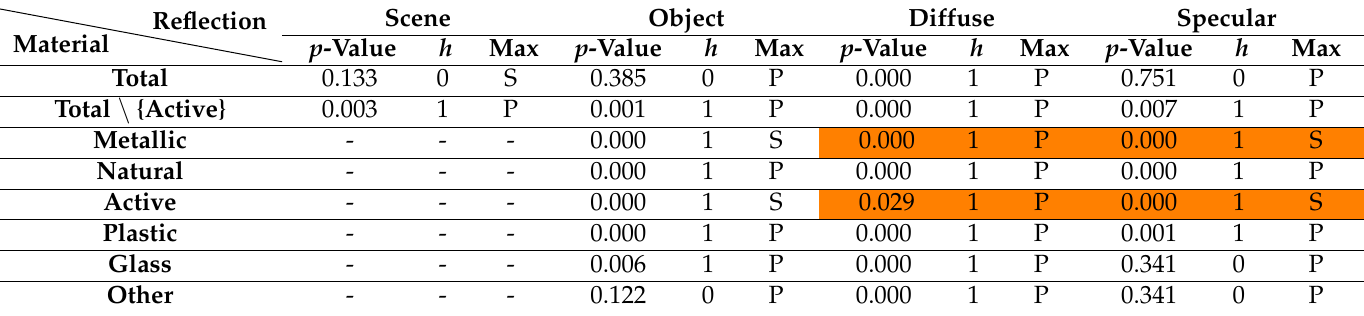
Table 5. Mann–Whitney U tests p -values and h for the 26 scenarios. h = 1 means the rejection of the null hypothesis, whereas h = 0 means a failure to reject the null hypothesis at 5% significance level. P (Polarization) or S (Spectral) indicates which modality has the maximum mean correlation coefficient (from Table 2). Cells in orange color have to be taken with